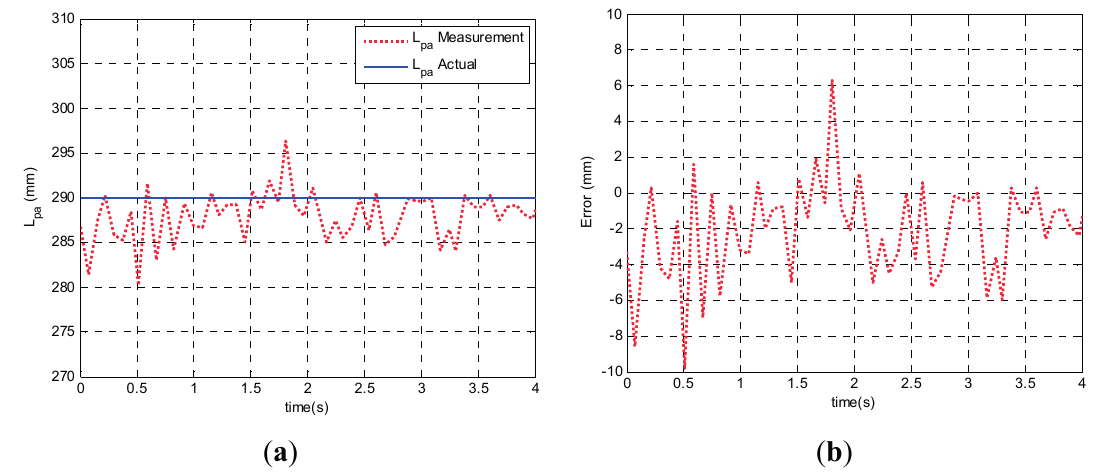
Figure 10. ( a ) A comparison of the measured width of the plate from the laser scanner and the actual value; ( b ) Error between measured width and actual